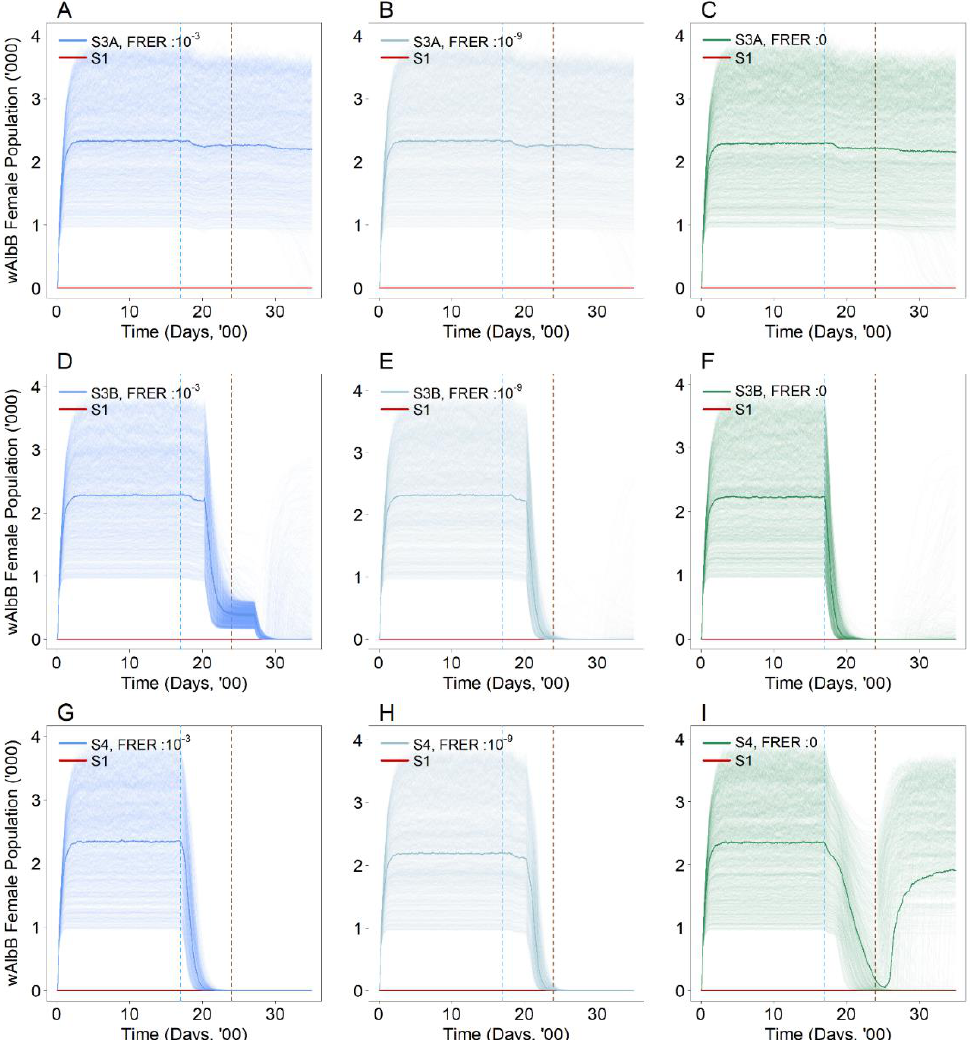
Figure 4. Number of Wolbachia ( w AlbB) female mosquitoes in the population with ( A ) FRER: 10 −3 , ( B ) FRER: 10 −9 and ( C ) FRER: 0 under the first strain female irradiation (S3A) with the same male release intensity. Number of wild type female mosquitoes in the population with ( D ) FRER: 10 −3 , ( E ) FRER: 10 −9 and ( F ) FRER: 0 under the first strain male and female irradiation (S3B) with the same male release intensity. Number of wild type female mosquitoes in the population with ( G ) FRER: 10 −3 , ( H ) FRER: 10 −9 and ( I ) FRER: 0 under the second strain introduction (S4) with the same male release intensity. The lighter shade solid lines represent the 1000 simulations, and the dark solid lines represent the median of the 1000 simulations. The blue and brown dotted vertical line represents the start and end of the intervention (S3A, S3B and S4) respectively. The red solid line represents the baseline scenario (S1).